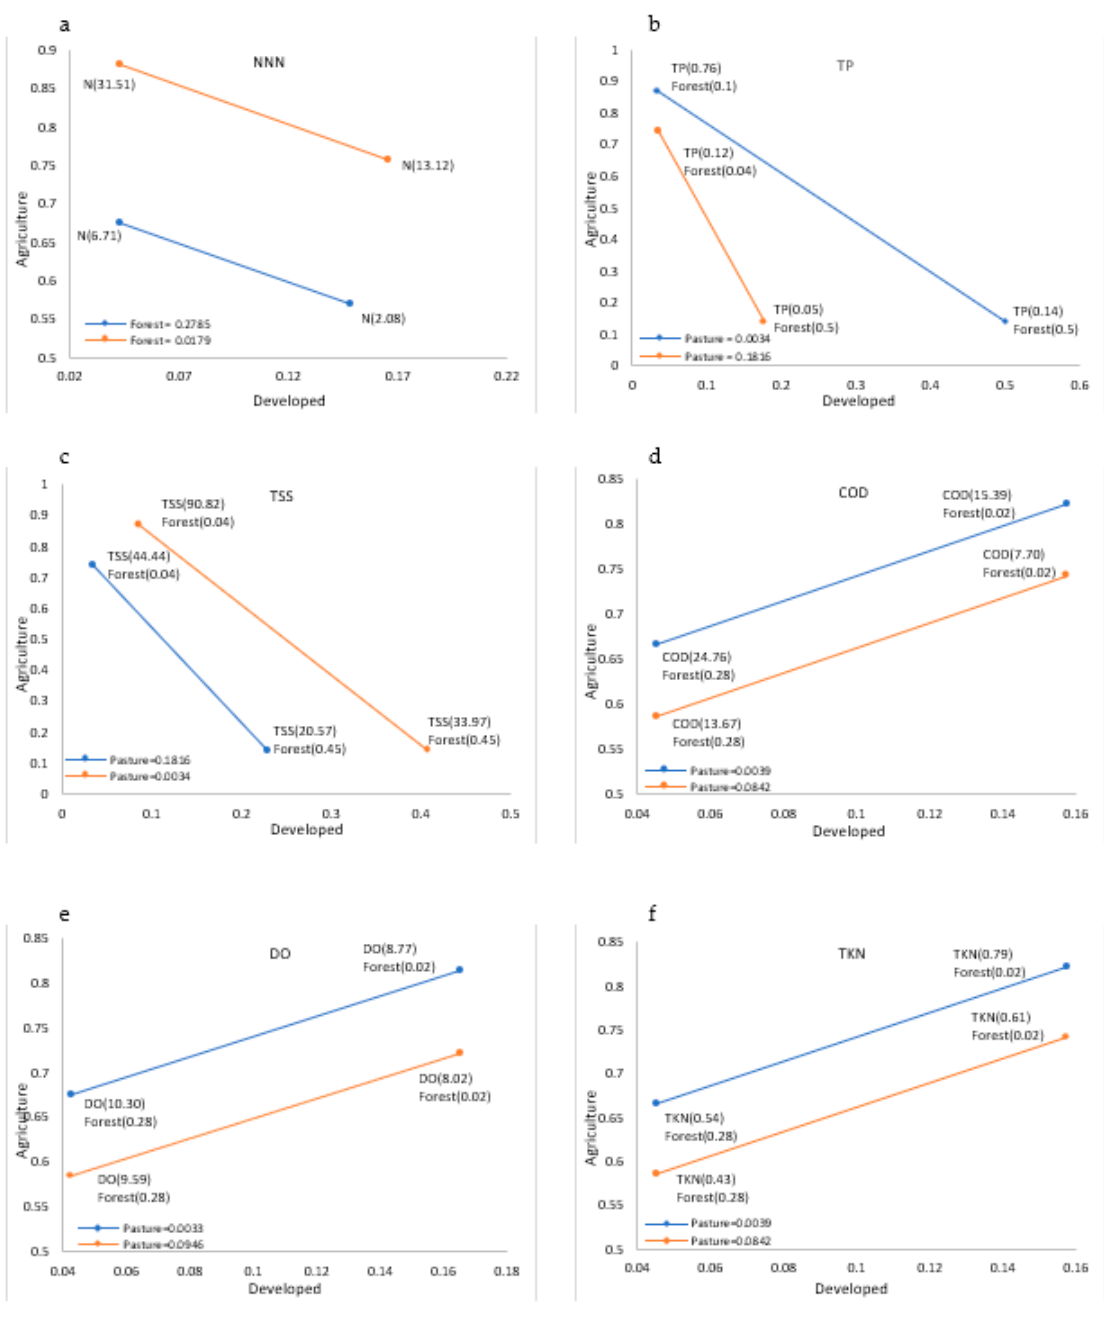
Figure 8. Changes in the mean water quality parameters at different reach distances. ( a ) NNN at 45 km, ( b ) TP at 10 km, ( c ) TSS at 10 km, ( d ) COD at 50 km, ( e ) DO at 45 km, and TKN at 50